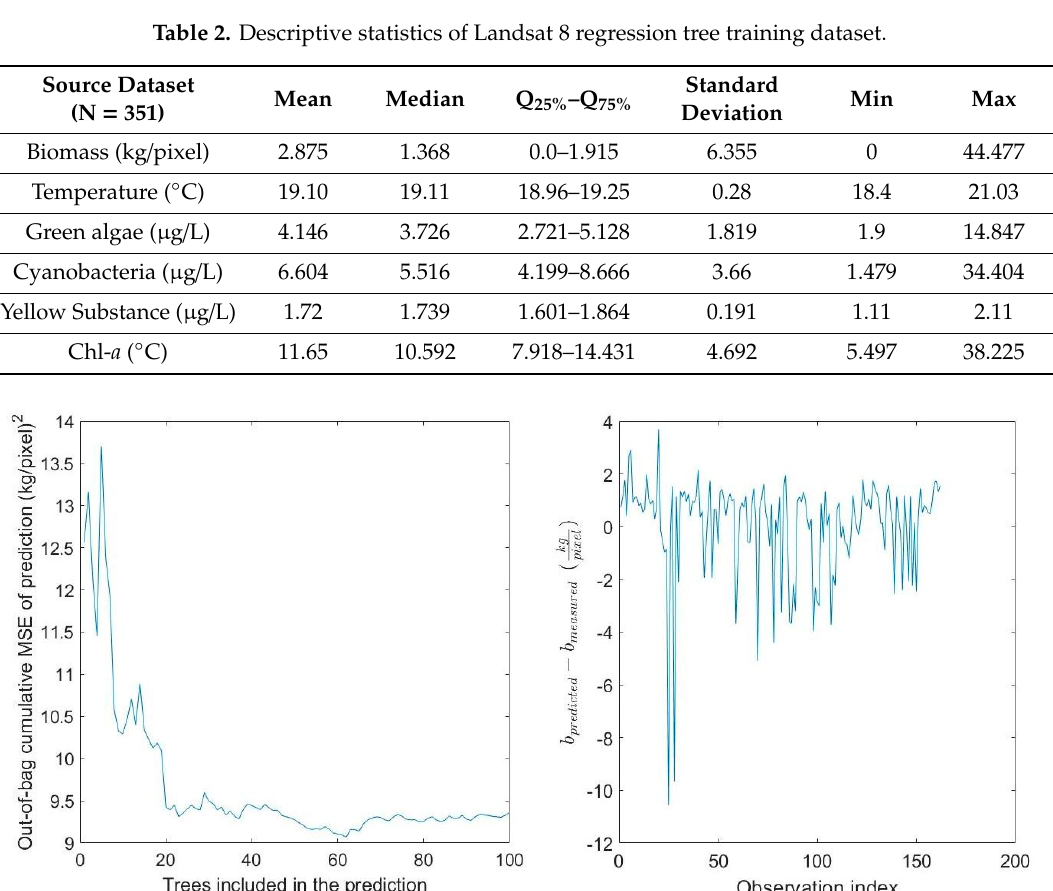
Table 2. Descriptive statistics of Landsat 8 regression tree training dataset.